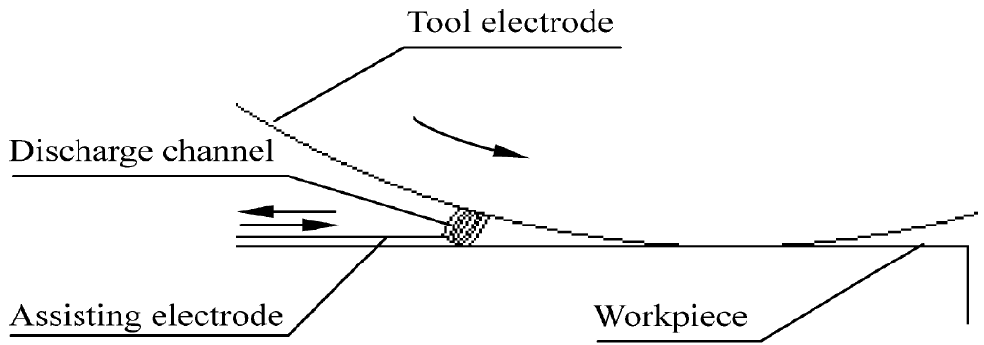
Figure 20. Principle of ED milling. Reproduced with permission from [57].